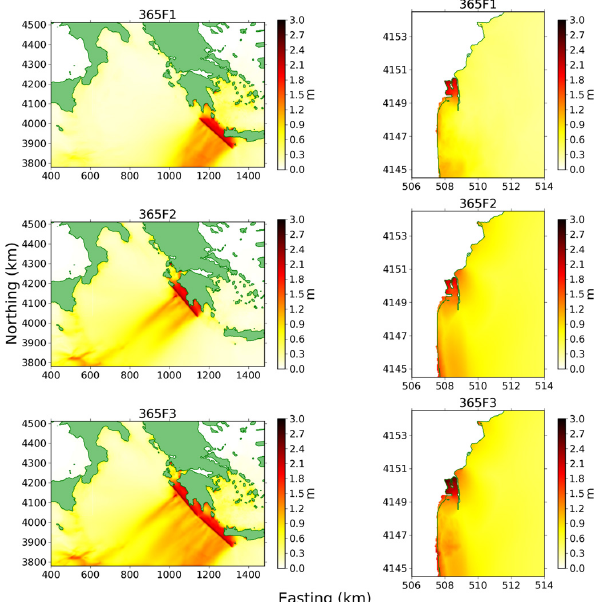
Fig. 7. Maximum water elevation for the three 365 F1, 365 F2 and 365 F3 scenarios (left column) and their corresponding detailed maximum inundation in Catania (right column).